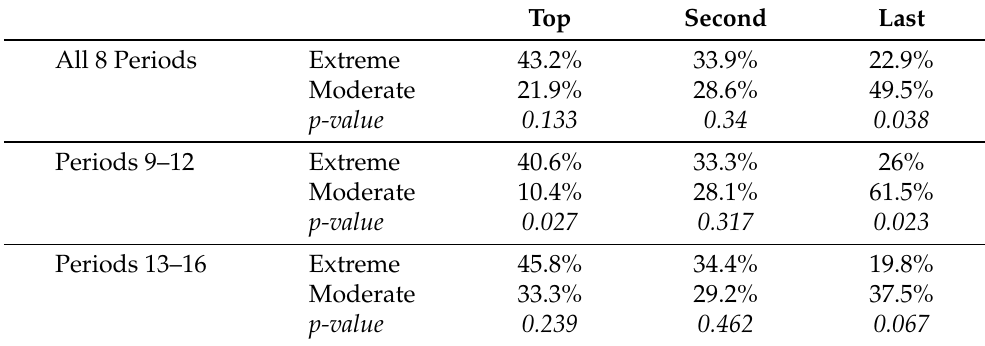
Table A3. Frequencies of the centrist at the three vote ranks (equiprobable